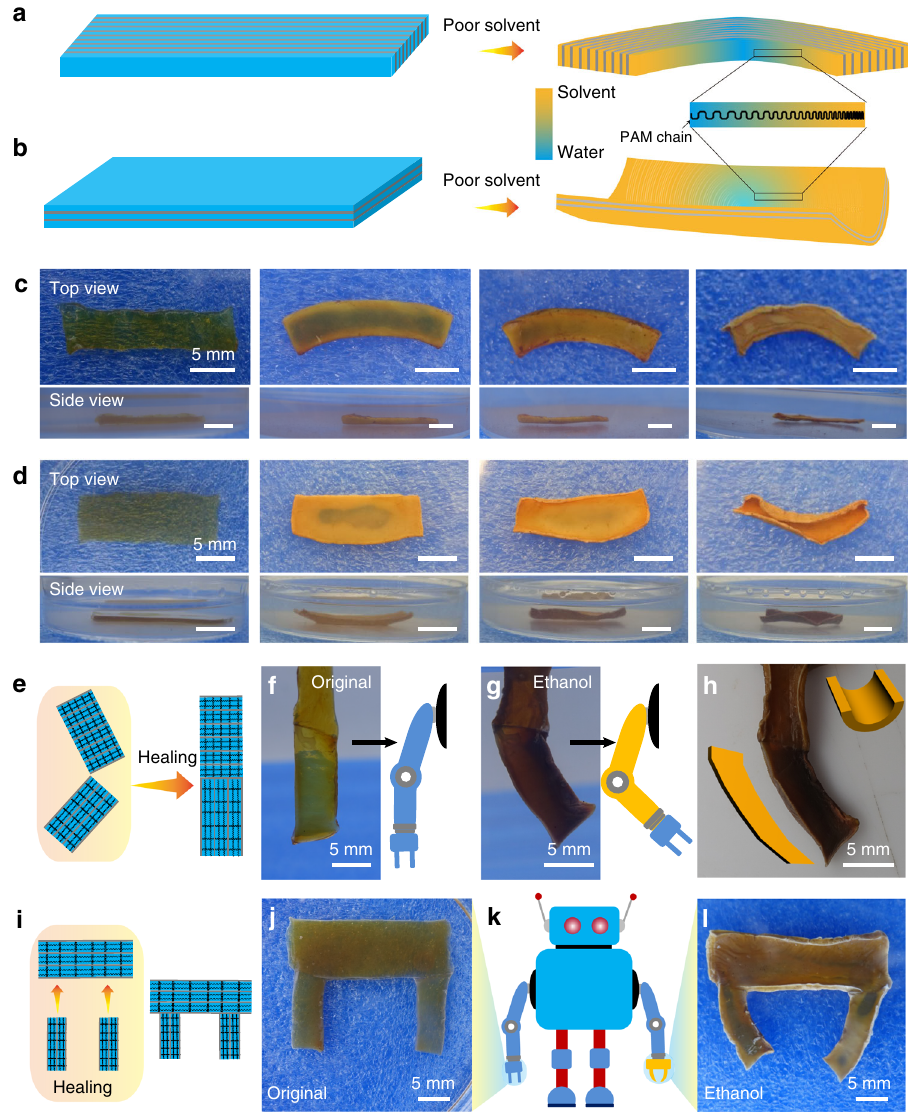
Fig. 6 Solvent-responsive anisotropic actuating performance. a , b Schematic illustration of actuator mechanism for the SNPP gel piece when exposed to poor solvent. In situ real-time optical monitoring the bending process of gel piece with the lamellae perpendicular ( c ) and parallel ( d ) to the top surface when placed in ethanol, from top and side views, respectively. All the scale bars in c , d are 5 mm. e Schematic illustration of assembly of robotic arm by two hydrogel pieces with lamellae in different orientations through a healing procedure. f , g Combined with the anisotropic structures, the integrated hydrogel piece exhibits distinct actuations varied from the parts when placed in ethanol, just like a robotic arm with vertical lifting. h Further optical image proves the in-plane and out-of-plane deformations. i Schematic illustration of complicated assembly of robotic hand composed of two fi ngers and one palm and conducted by three hydrogel pieces with lamellae in different orientations through a healing procedure. j – l The integrated hand shows a grasping